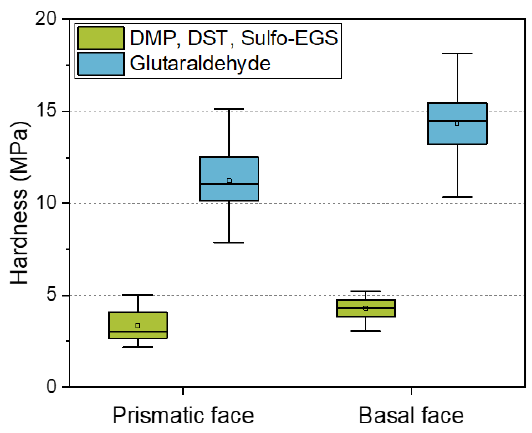
Figure 4. Comparison of the hardness of wild-type crystals cross-linked using the different linkers for 24 h. Results of WT HheG, cross-linked with glutaraldehyde, were adapted with permission from ref. [20]. Copyright © 2019, American Chemical Society.